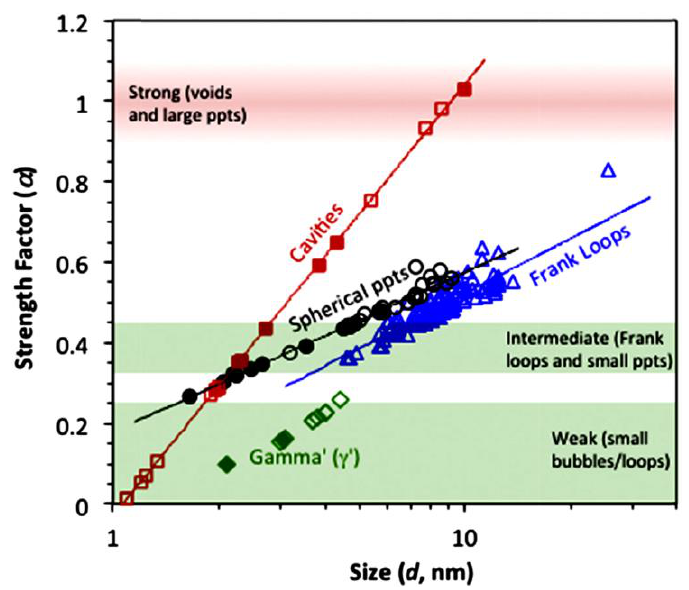
Figure 4. Calculated size-dependent strength factor at room temperature for spherical incoherent precipitates ppts (circles), coherent ppts (diamonds), Frank loops (triangles), and cavities (squares). Reproduced with permission from [15].